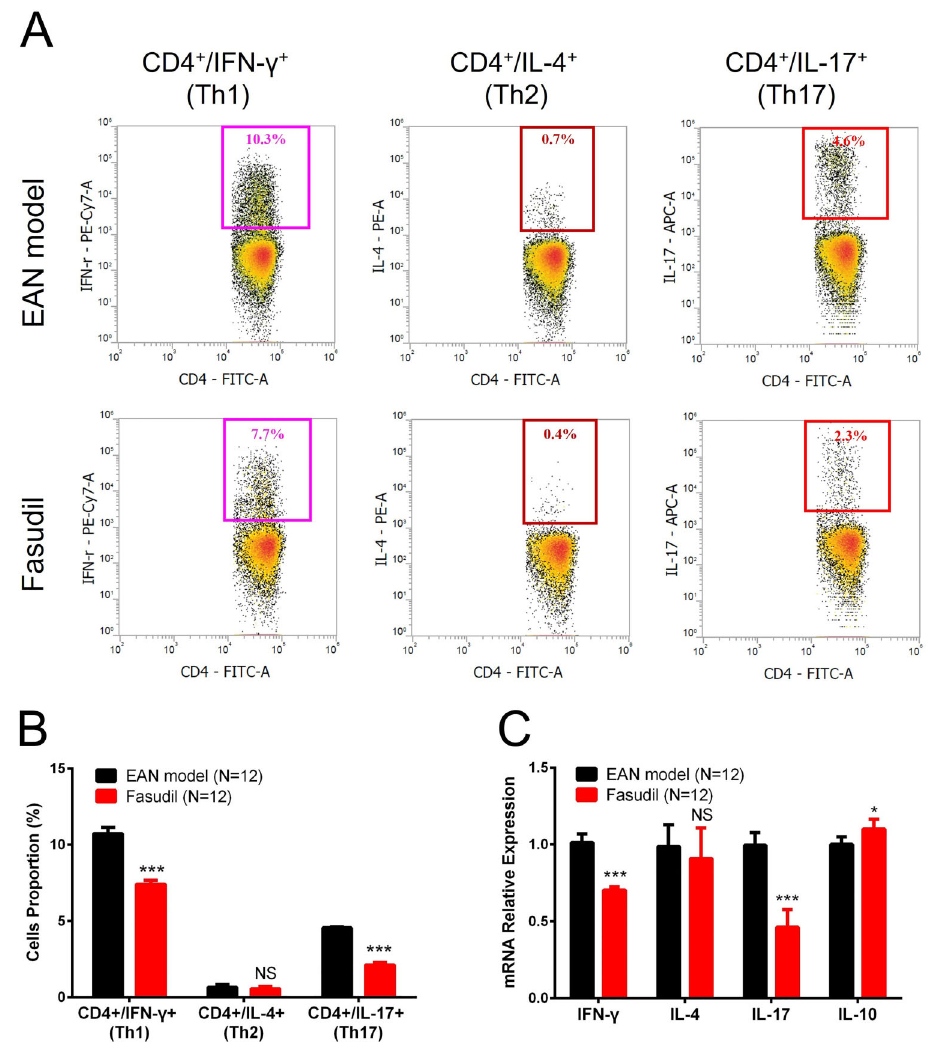
Figure 5. Th1, Th2, and Th17 cell proportion in splenocytes after induction of experimental autoimmune neuritis (EAN). Fasudil decreased CD4 + IFN- g + cell proportion and CD4 + IL-17 + cell proportion, but did not affect CD4 + IL-4 + cell proportion in splenocytes at day 28 ( A and B ). Fasudil also reduced interferon (IFN)- g and interleukin (IL)-17 mRNA expression, elevated IL-10 expression, while did not affect IL-4 mRNA expression ( C ). Data are reported as mean and SD. *P o 0.05, ***P o 0.001 compared to the EAN model ( t